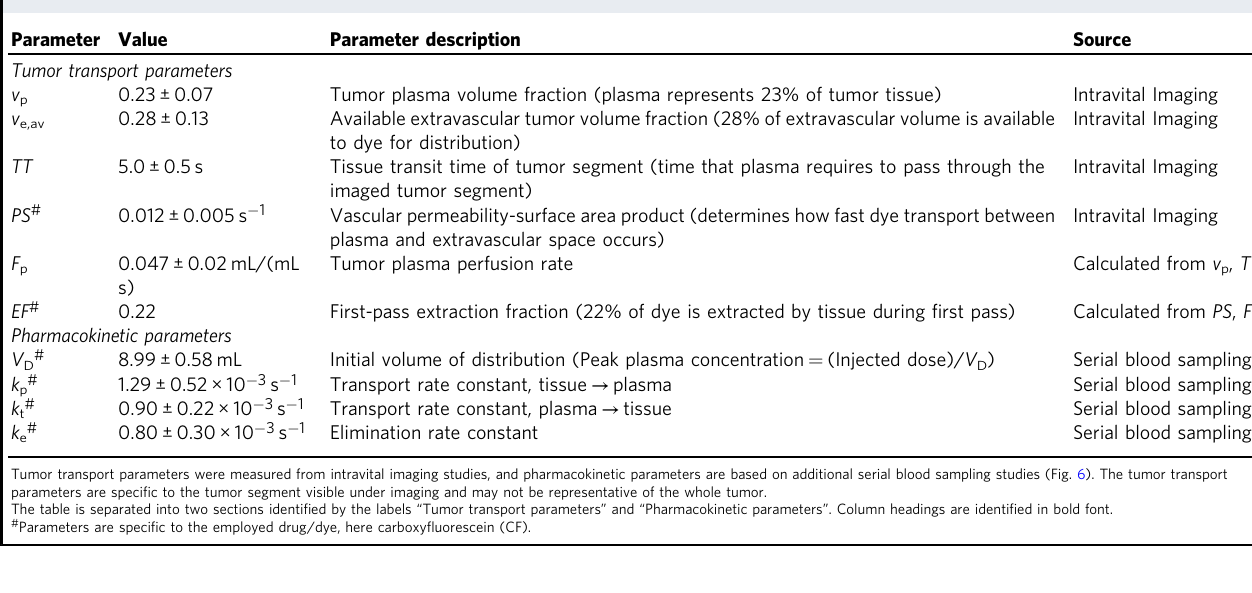
Table 1 In vivo measured tumor transport parameters and pharmacokinetic parameters.